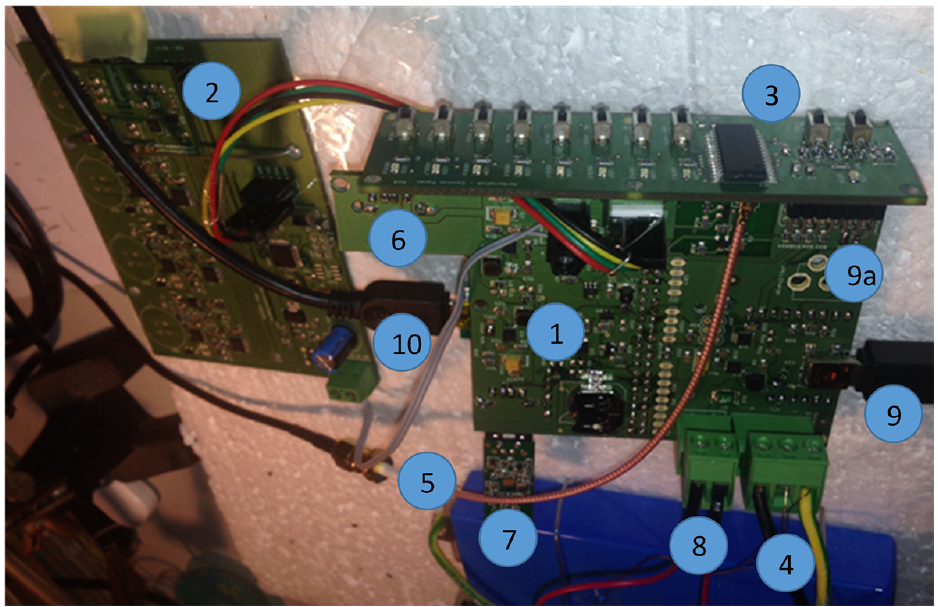
Figure 3. Hardware components of